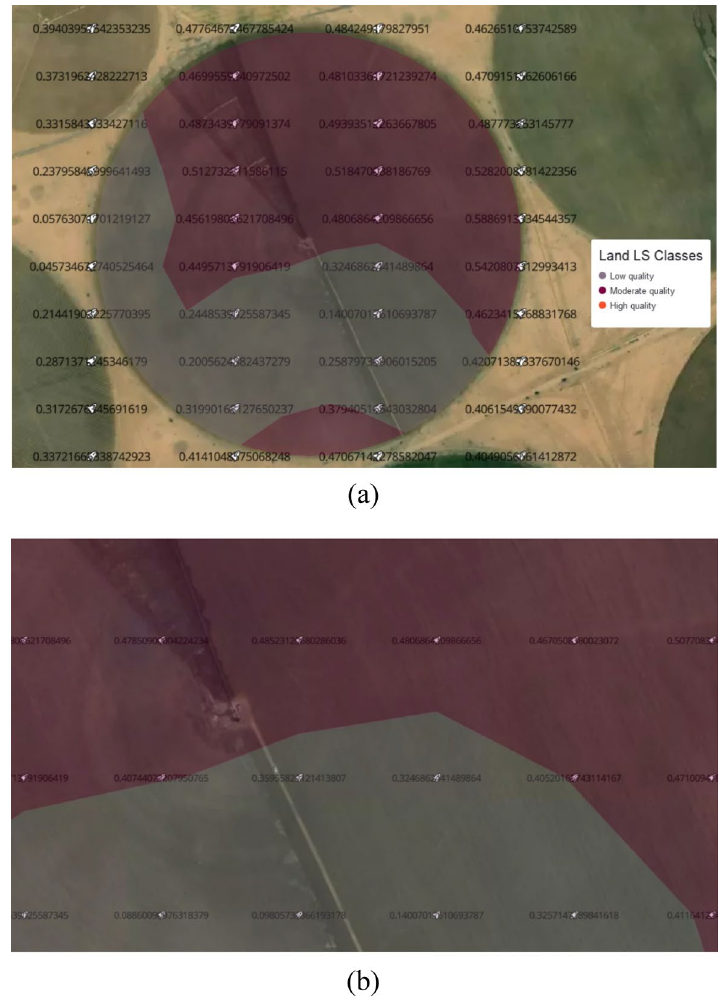
Figure 22. The generated LS interpolation grid and isobands, ( a ) the grid and isobands of the whole area, ( b ) a zoom in specific boundary between two